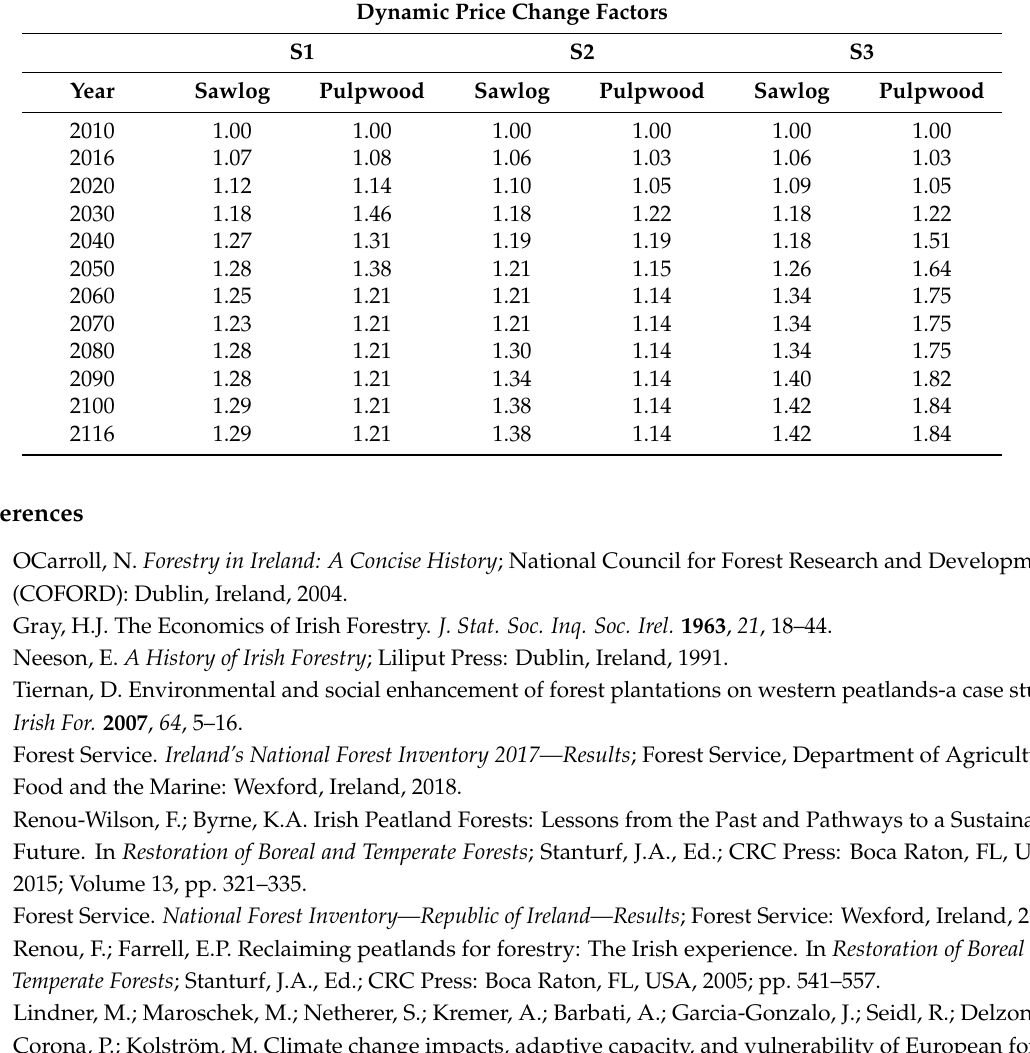
Table A6. Price change factors used in the three scenarios. Although the table only contains values for every decade, the price change factor was linearly interpolated and implemented on an annual basis. For example, a factor of 1.00 corresponds to no price change compared to the 2010 initial price and a factor of 1.10 corresponds to a 10% price